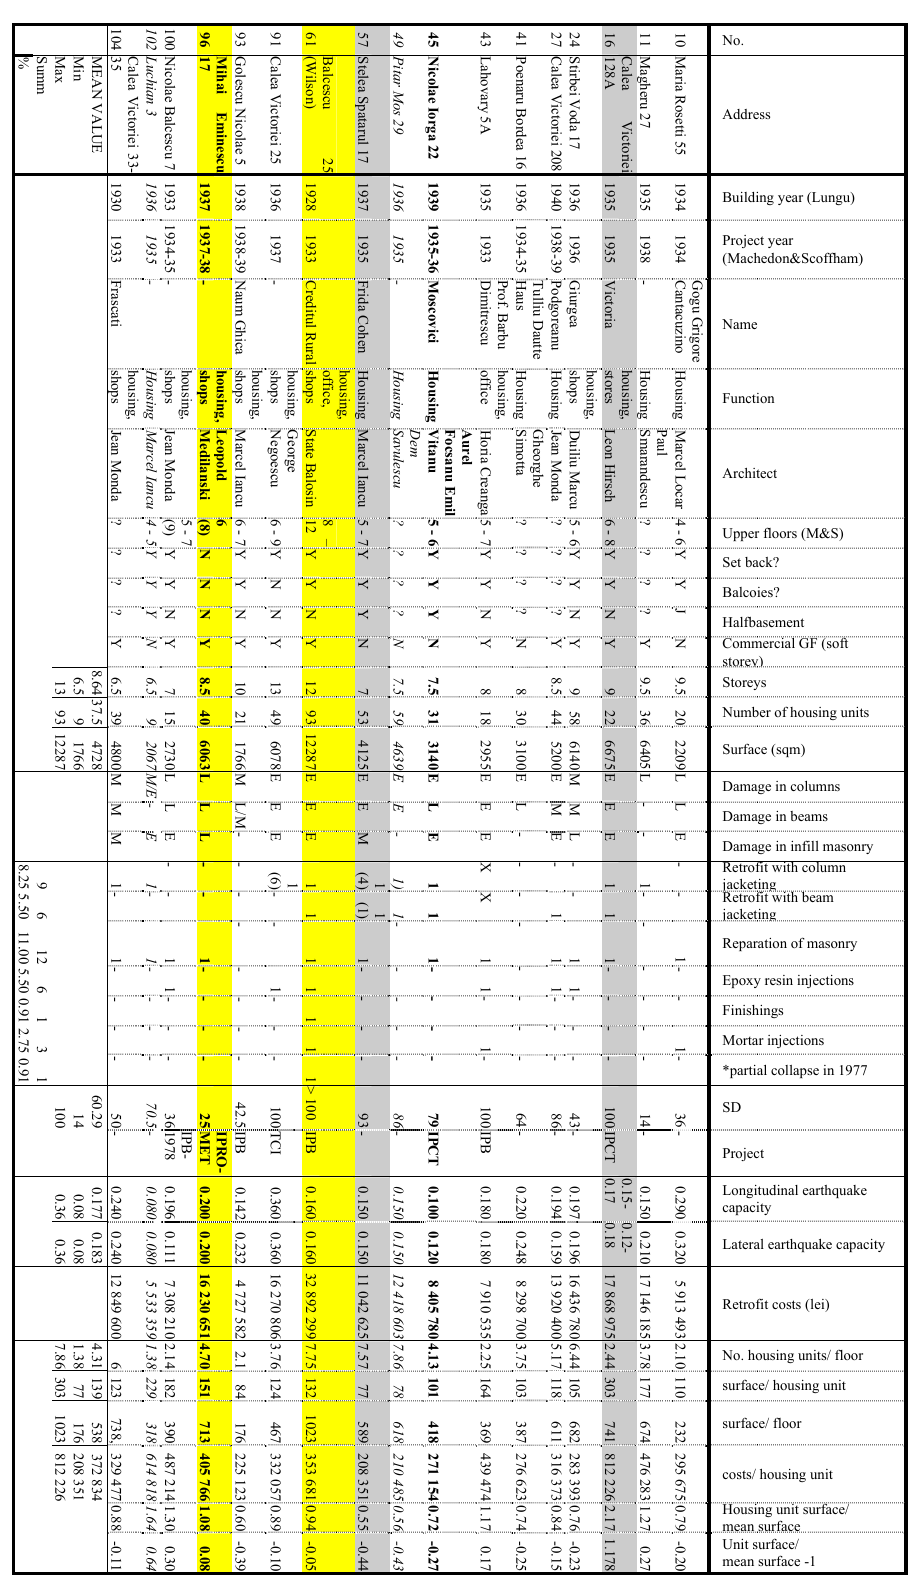
Table 2. List of vulnerable architecturally significant buildings in Bucharest (risk category